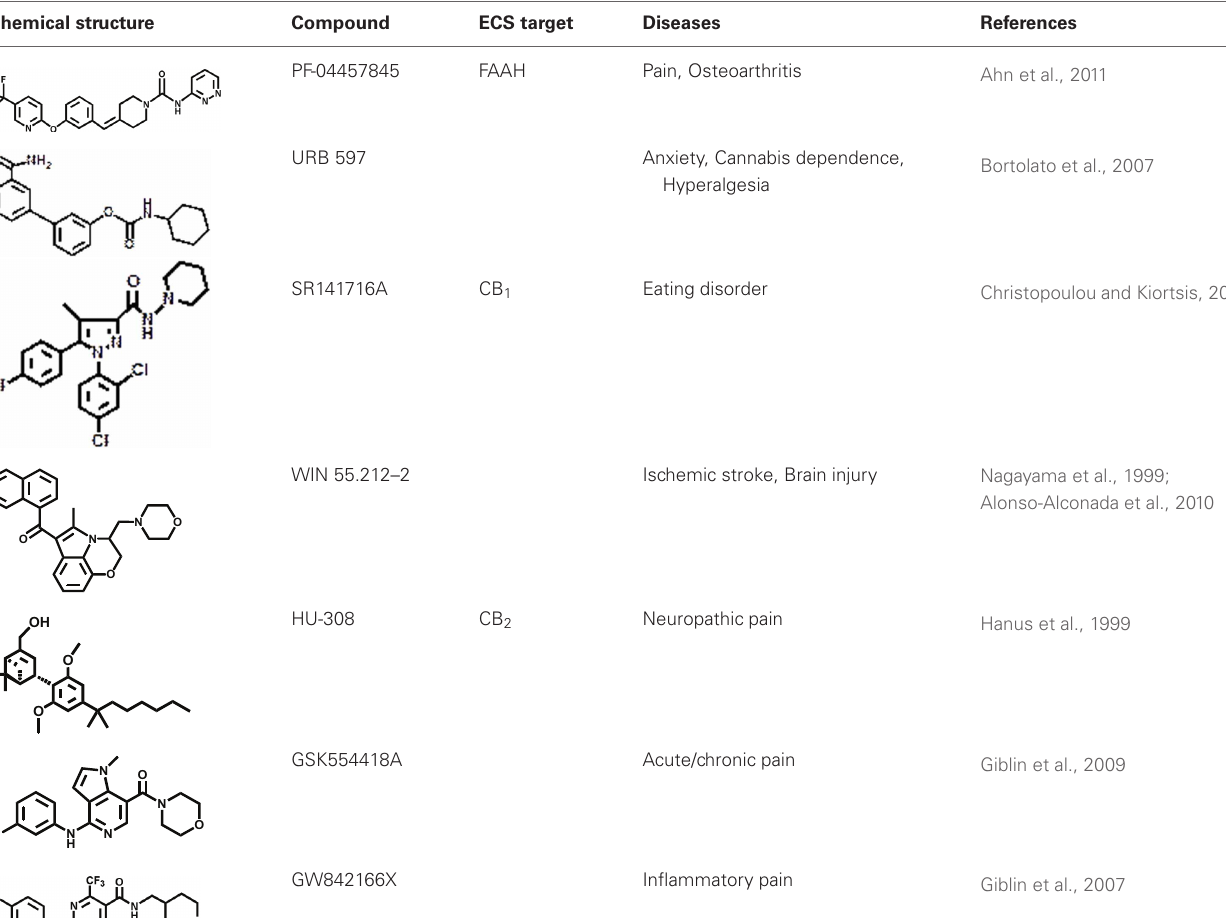
Table 2 | Chemical structures and therapeutic potential of some ECS-targeted molecules. Chemical